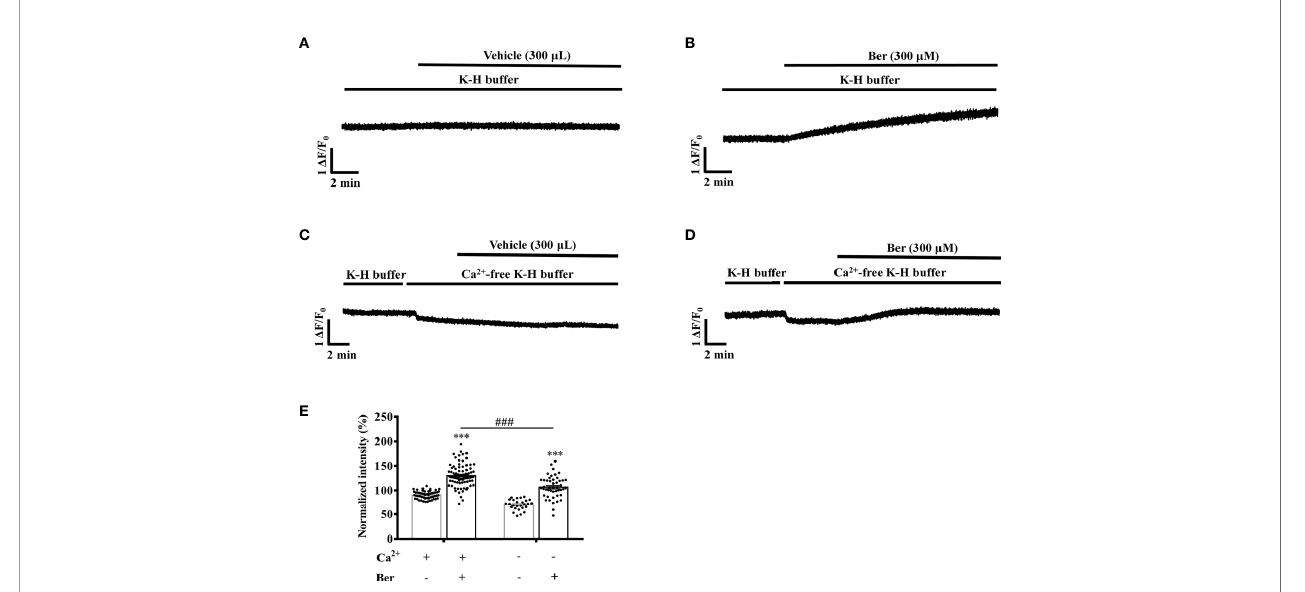
FIGURE 9 | The removal of extracellular Ca 2+ hindered the berberine-induced increase in the intracellular Ca 2+ level of freshly isolated LV myocytes. (A – D) Original Ca 2+ imaging recordings of the LV myocytes treated with vehicle (A) and 300 m M berberine (B) ; vehicle (C) and 300 m M berberine (D) in the Ca 2+ -free modi fi ed Krebs-Hensseleit (K-H) buffer, respectively. (E) Summary data showing that the removal of extracellular Ca 2+ signi fi cantly hindered the 300 m M berberine-induced increase in the intracellular Ca 2+ level of LV myocytes. The numbers of repeats are as follows: vehicle control of 300 µM Ber, n = 57, N = 3; 300 µM Ber, n = 83, N = 3; vehicle control of 300 µM Ber in the Ca 2+ -free modi fi ed K-H buffer, n = 27, N = 3; 300 µM Ber in the Ca 2+ -free modi fi ed K-H buffer, n = 47, N = 3; n and N are the numbers of LV myocytes and rats, respectively. Ber stands for berberine. ***p < 0.001 vs. vehicle control group; ### p < 0.001 vs. Ber-treated group in the normal modi fi ed K-H buffer; two-way ANOVA with Tukey's multiple comparisons test.